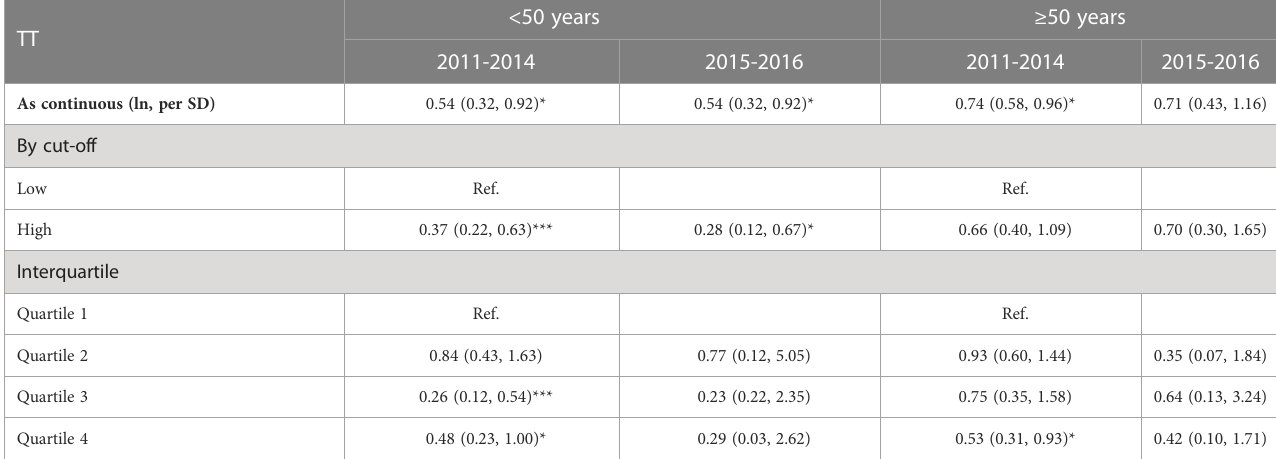
TABLE 3 The association between TT and MetS in female population from different age stages (<50 years and ≥ 50 years) a .